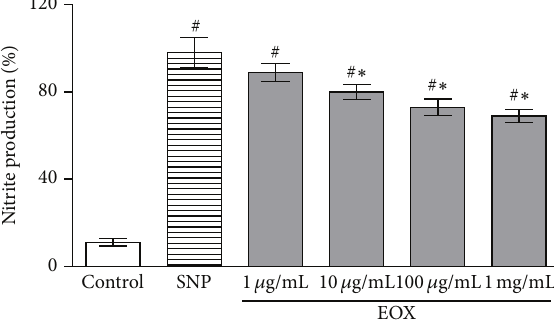
Figure 2: NO-scavenging activity. Control means basal NO production of vehicle (DMSO 10%) in the absence of a NO generator source (without SNP); SNP group reflects nitrite production by sodium nitroprusside alone, considered 100% of NO production. The effect of different concentrations of EOX against SNP was determined by the Griess method. Values represent mean ± S.E.M., 𝑛 = 4 , experiments in triplicate. # 𝑃 < 0.001 versus control; ∗ 𝑃 < 0.01 different versus SNP (ANOVA followed by Tukey’s test).